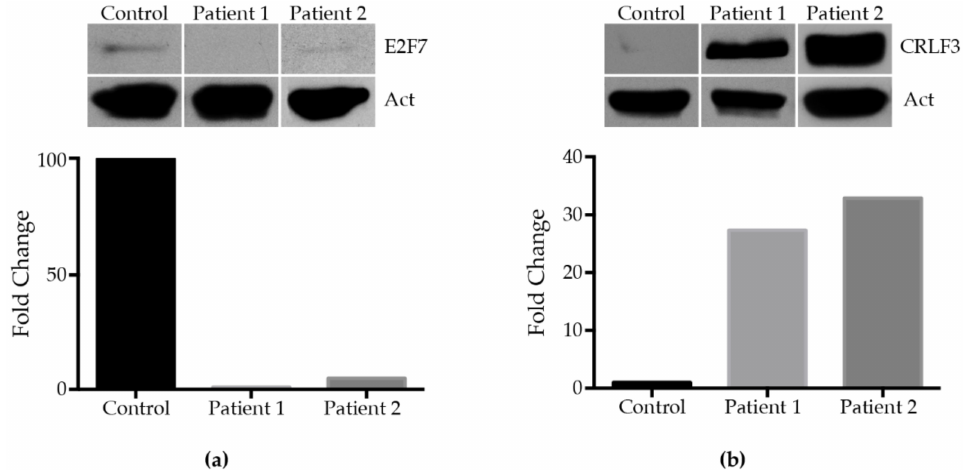
Figure 8. Immunodetection of ( a ) E2F7 and ( b ) CRLF3. In each case, immunodetection of actine was used as a control. Intensity of detected E2F7 and CRLF3 bands was quantified, and graphics performed with GraphPad Prism 6